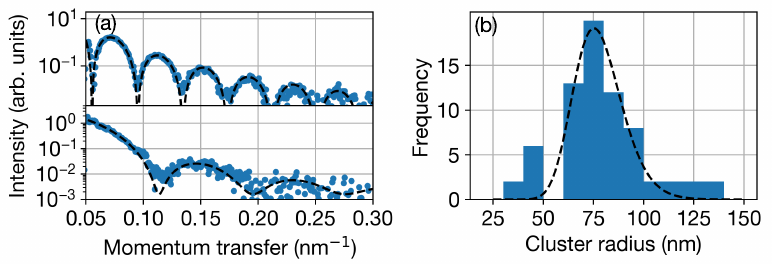
Figure 3. ( a ) Characteristic radial profiles of diffraction images. The radii of the Xe clusters giving the top and bottom and the profiles are 81 nm and 39 nm, respectively. The formula of the fitting curves (black dotted lines) is described in [39]. ( b ) The histogram of radii of the observed Xe clusters. The black dotted line is a fitting curve based on the log-normal distribution of cluster size and gives the average radius of 80 nm.